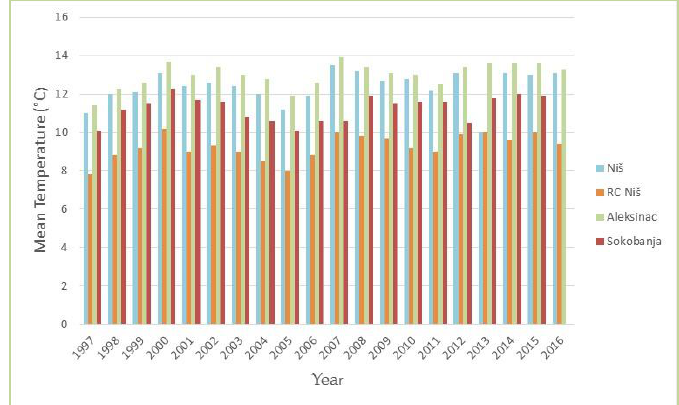
Figure 3 : Mean annual temperature in the Niš region from Figure 3. Mean annual temperatures in the Niš region from 1997 to 2016, obtained from four 1997 to 2016, obtained from four meteorological stations. meteorological